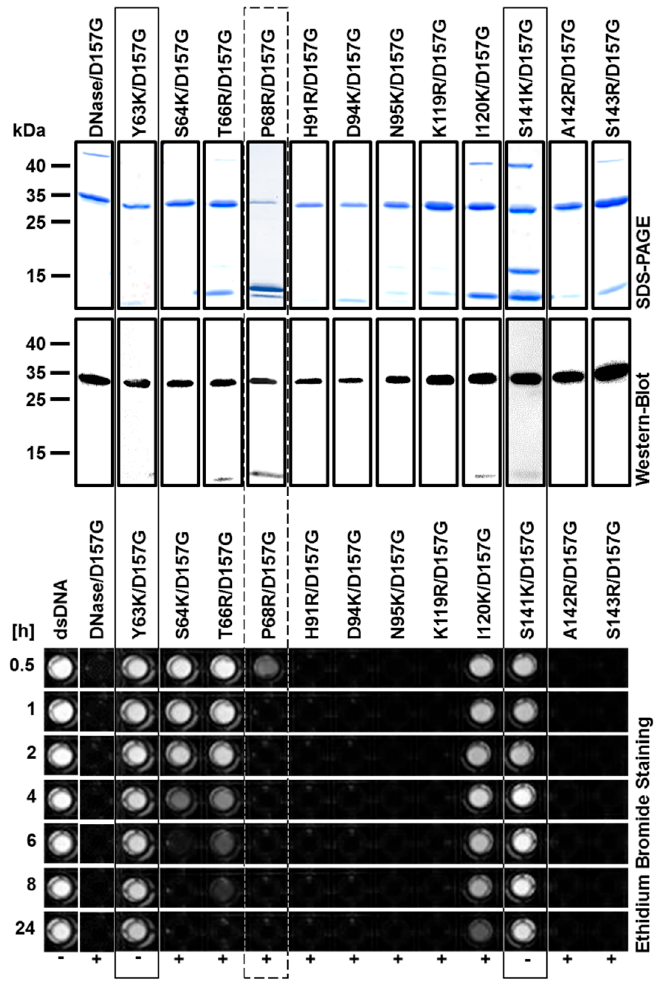
Figure 2. Biochemical and enzymatical analysis of purified nuclease mutants. SDS-PAGE results showed the purity of HIS-tagged nucleases (29 kDa) after a two-step purification approach composed of affinity and ion exchange chromatography (upper row). Western blotting analyses confirmed the presence of HIS-tagged nucleases (middle row). Qualitative activity assays used ethidium bromide staining in 96-well plates (lower row): white colored dots indicate the presence of ethidium bromide intercalating into DNA and grey dots indicate incomplete degradation, while a complete loss of fluorescence is due to complete DNA degradation. Solid line boxes—inactive variants Y63K/D157G and S141K/D157G were purified in non-optimized gravity flow experiments. Dashed line box—variant P68K/D157G was produced in expression strain E. coli Veggie BL21(DE3) pLysS. Note: “+” indicates activity and “ − ” indicates inactivity. SDS-PAGE results, including all purification steps, are shown in Figure A2 Appendix A.